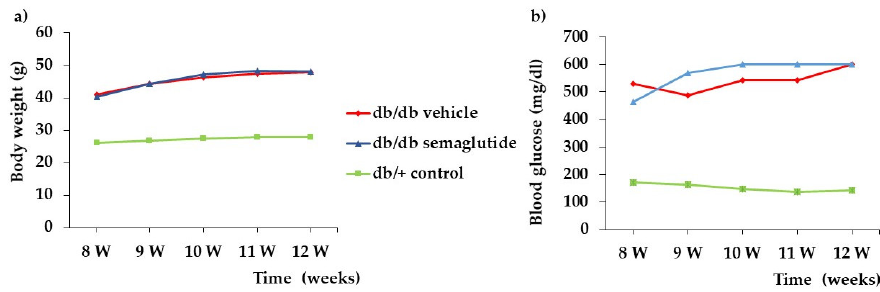
Figure 1. Evolution of blood glucose ( a ) and body weight ( b ) in the experimental groups.